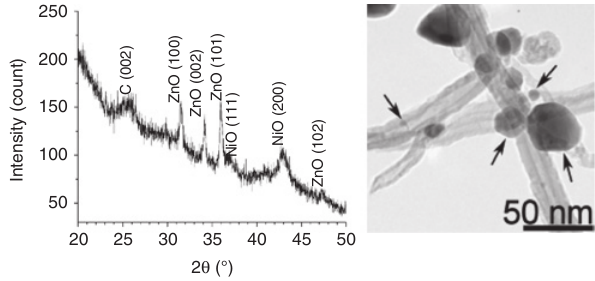
Figure 2: X-ray powder diffraction (XRD) pattern and energy filtered transmission electron microscopy (EFTEM) micrograph of (ZnO) Ni /carbon nanotube (CNT) catalyst. 10 10